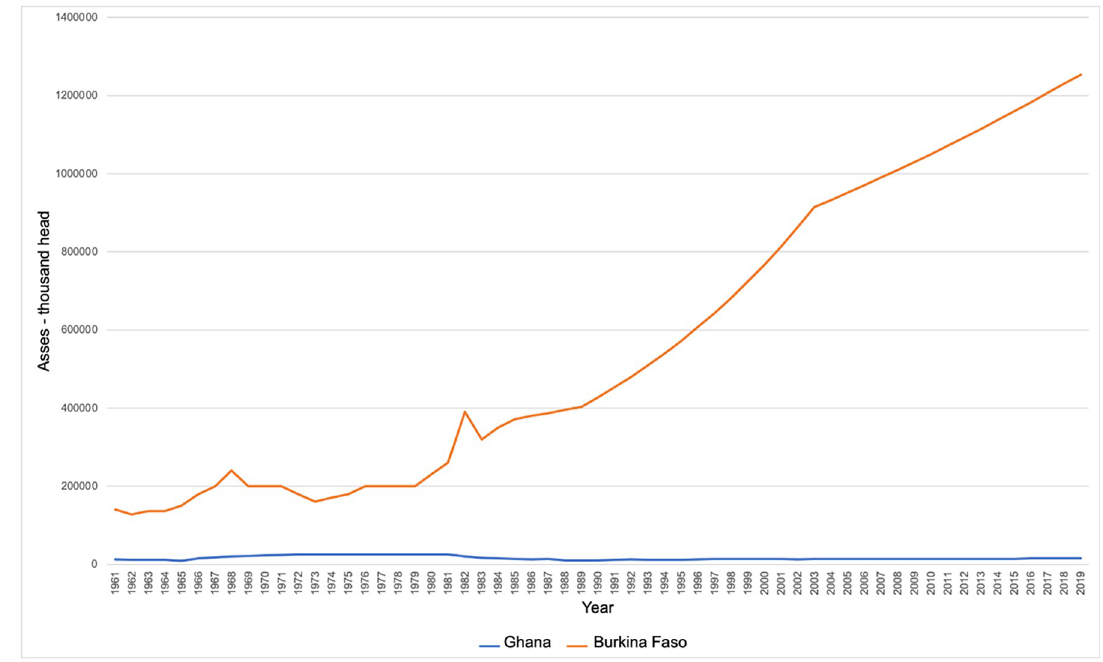
Fig 4. Donkey populations of Ghana and Burkina Faso 1961–2019. Notes: the quality of the data differs, with population estimates for both countries based on official data, FAO estimates and FAO data based on imputation methodology. FAO. Source: FAOSTAT/asses